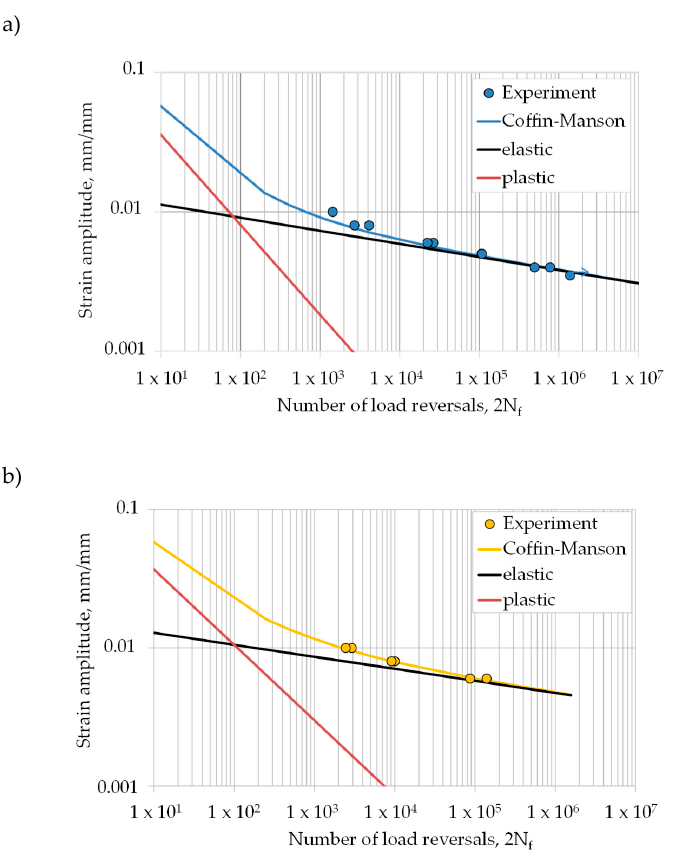
Figure 9. Softening behavior of Ti-6Al-4V for ( a ) vertically oriented specimens and ( b ) horizontally oriented specimens.